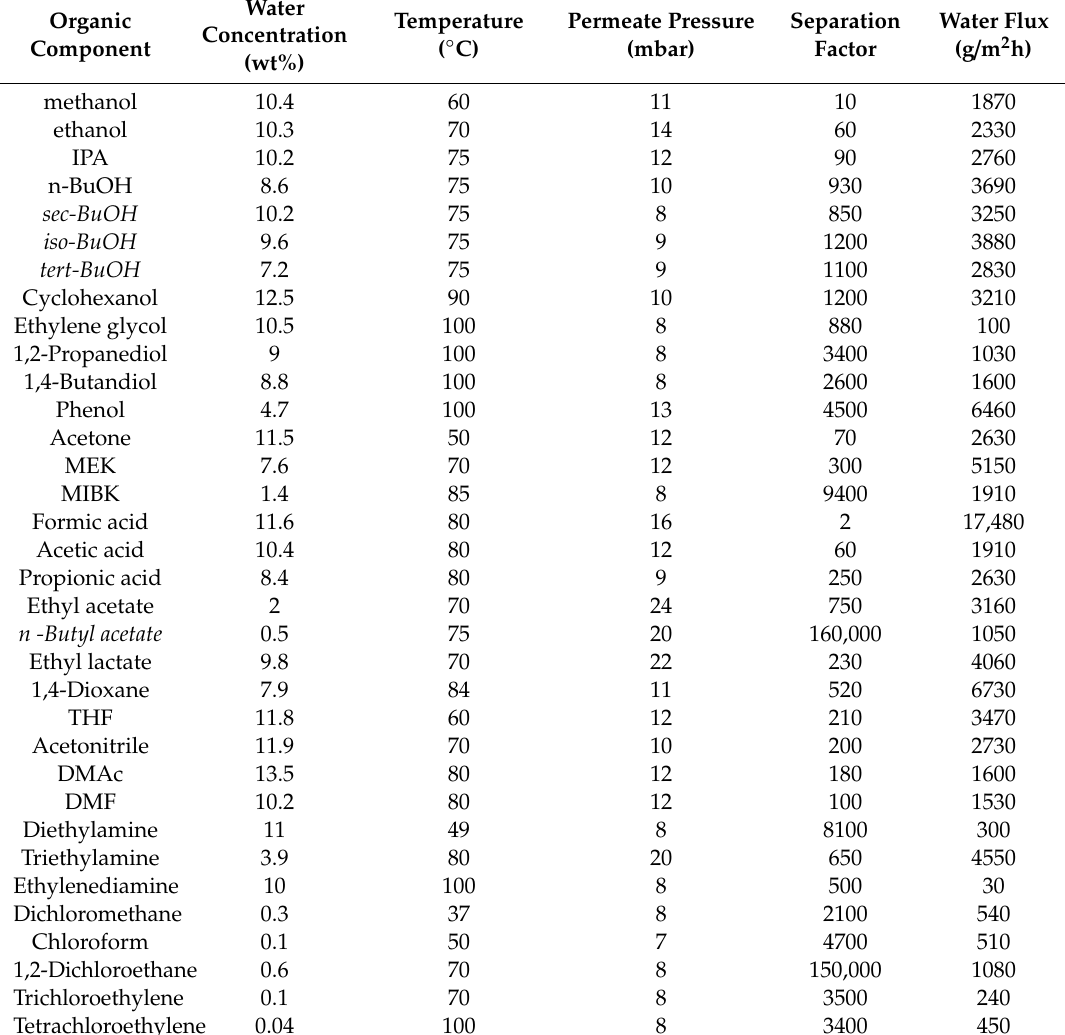
Table 3. Pervaporation performance for various solvents in their aqueous solutions, separation achieved using the commercial silica membrane, ECN (The Netherlands). Adapted from [71], with permission from Copyright (2005), Elsevier Science